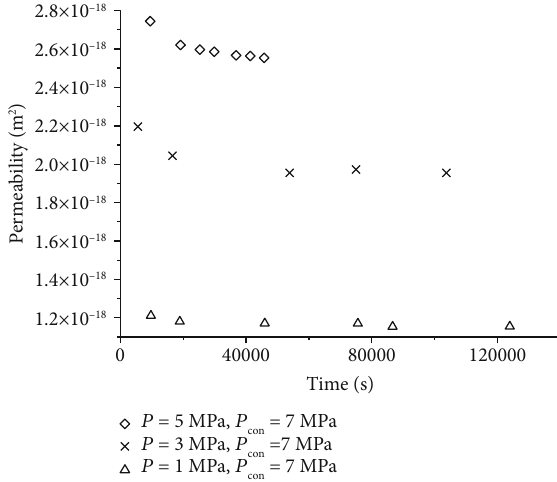
Figure 7: Permeability revolutions with time under constant con fi ning stress